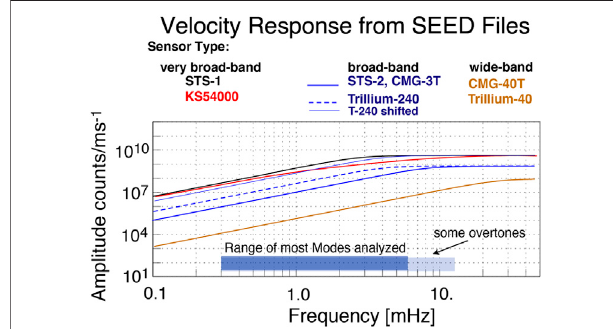
FIGURE 2 | Long-period protion of the velocity response of sensors used in broadband seismology. The Wielandt Streckeisen STS-1 vault seismometer (corner period 360 s) and the Teledyne-Geotech KS54000 borehole seismometer are considered very broadband sensors, while the STS-2 and the Güralp CMG-3T (corner period 120 s) are broadband sensors. The Nanometrics Trillium T-240 (corner period 240 s) falls in between. Sensors with a corner period of 40 s (e.g. the Trillium T-40 or the CMG-40T)arewidebandsensors(oftenmislabelledasbroadband).Forbetter comparison of the low-frequency roll-off of the Trillium 240 with that of the STS-1, it is also plotted with a thin blue line and shifted to match the STS-1 response at 10